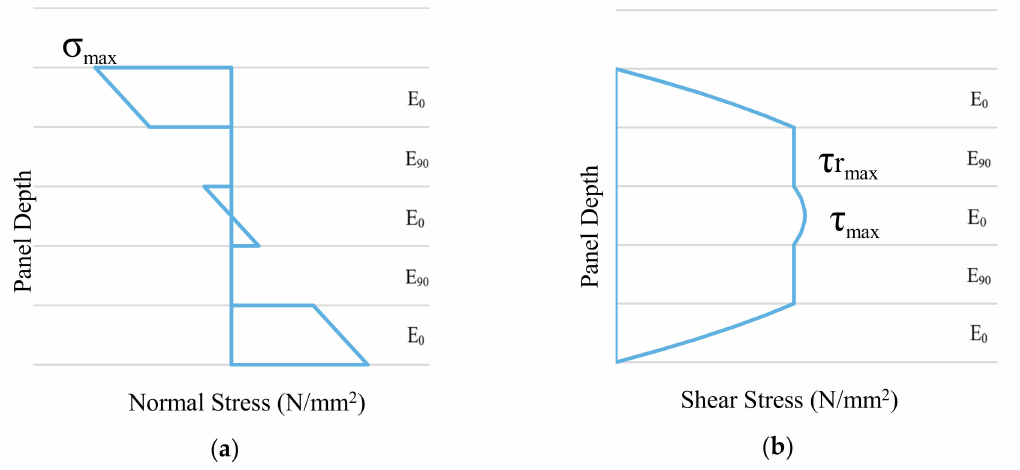
Figure 2. CLT element loaded out of plane. ( a ) Normal stress distribution through a five-layer panel assuming E 90 = 0 N/mm 2 ; ( b ) shear stress distribution assuming E 90 = 0 N/mm 2